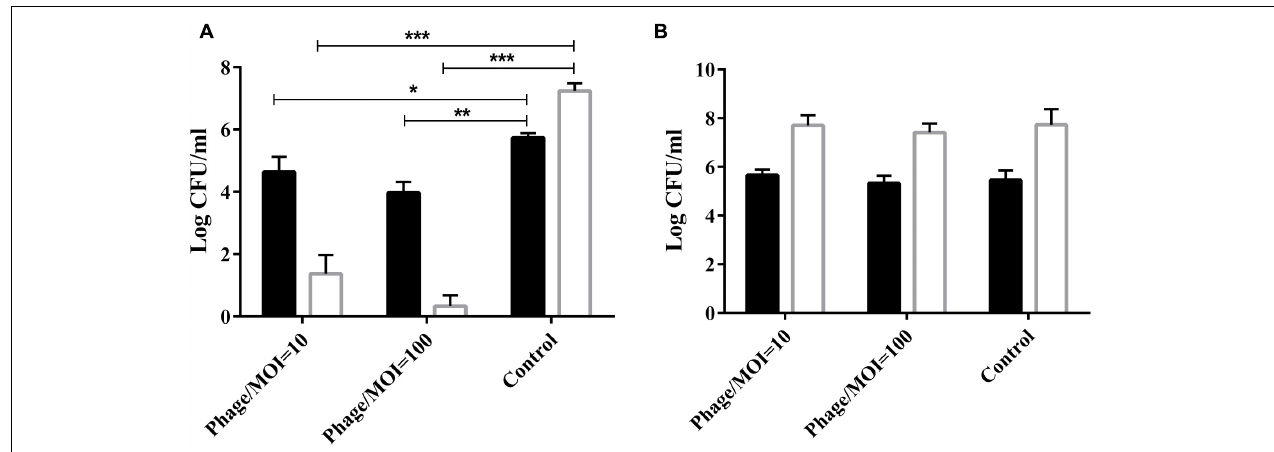
FIGURE 2 | In vitro activity of the phage against the wild-type and capsule-deficient mutant strains. (A) In vitro activity of the phage against wild-type P. multocida strain HB03. The phage was mixed with the bacteria at a MOI of 10 or 100 and then cultured at 37 ◦ C for 30 min ( (cid:4) ) or 60 min ( (cid:3) ). Results show the number of viable bacteria following incubation. Experimental data were analyzed by two-way analysis of variance and are expressed as the mean ± SD. The viable cell counts in each of the treatment groups were compared with that of the control, with significant differences indicated by ∗ P < 0.05; ∗∗ P < 0.01; and ∗∗∗ P < 0.001. (B) In vitro activity of the phage against the capsule-deficient P. multocida strain. Conditions and data interpretation were the same as described in (A).